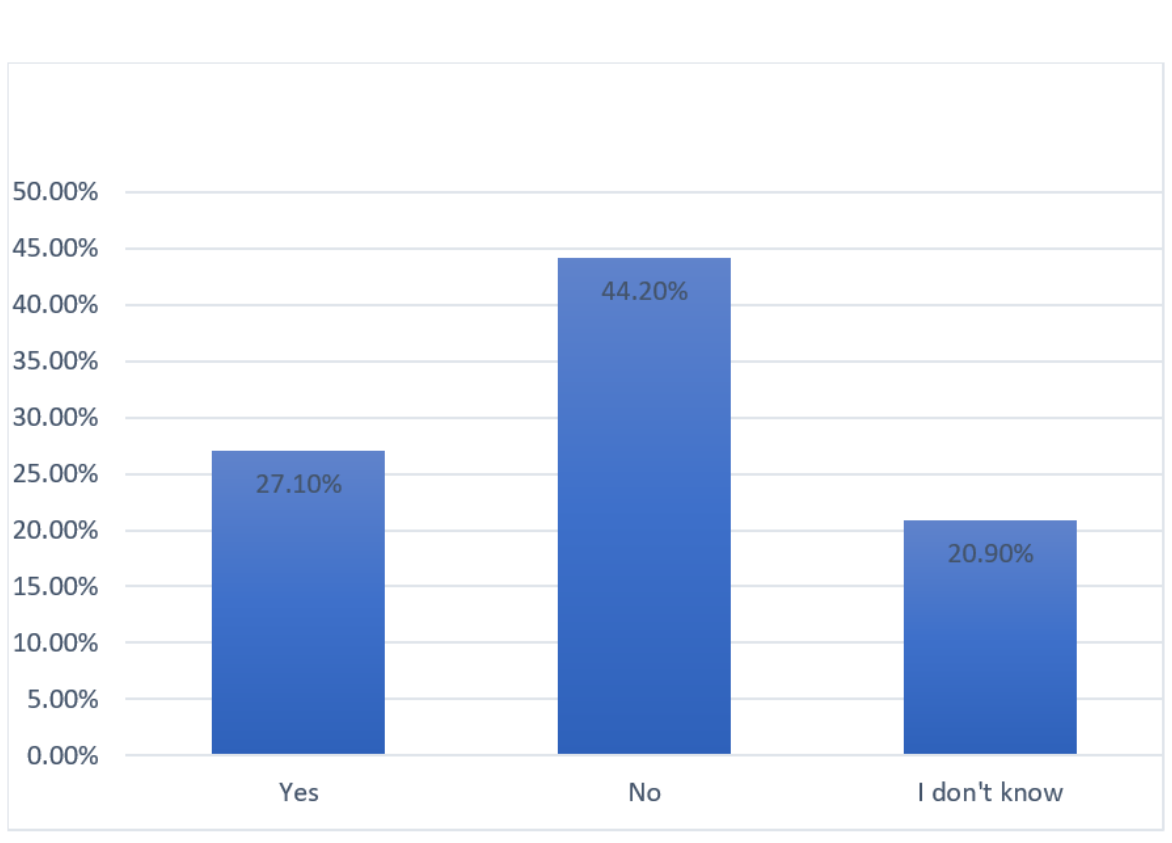
Figure 4. Interested in trying a psychological online intervention.